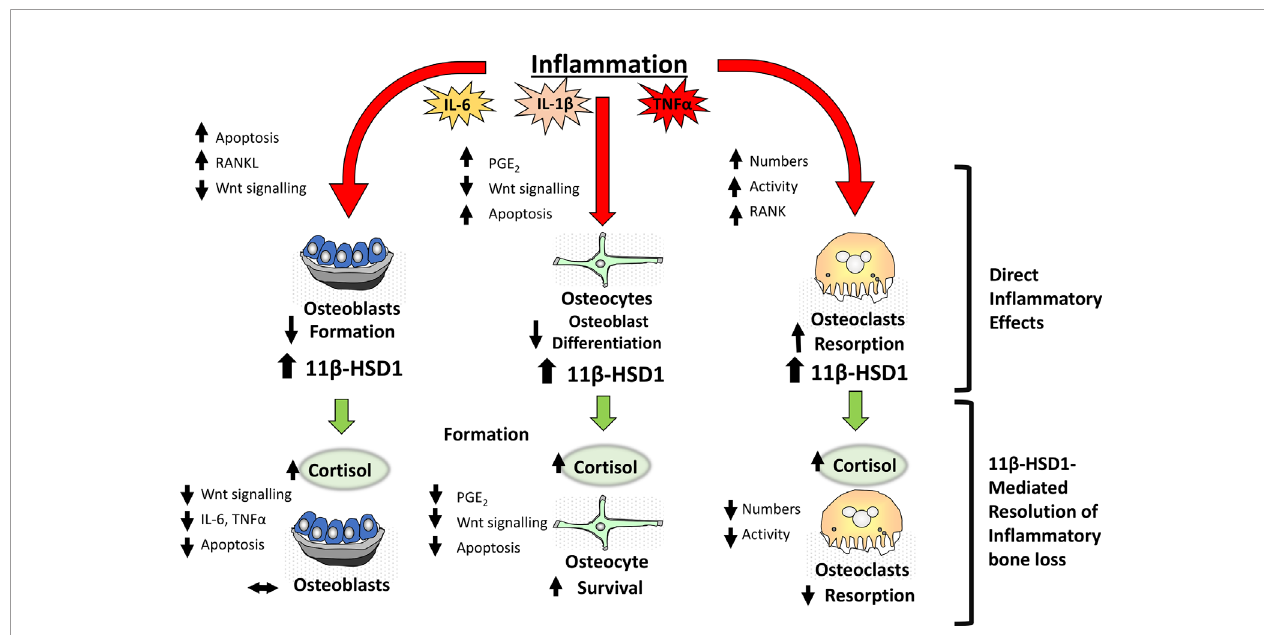
FIGURE 2 | During in fl ammation within bone, pro-in fl ammatory factors including IL-6, IL-1 b and TNF a have direct effects on bone cells including osteoblasts, osteocytes and osteoclasts resulting in a net loss in bone in addition to a signi fi cant induction of the corticosteroid activating enzyme 11 b -HSD1. This in turn drives an anti-in fl ammatory resolution response where increased cortisol activation by 11 b -HSD1 promotes a reduction in osteoclastic bone resorption thus suppressing in fl ammatory bone